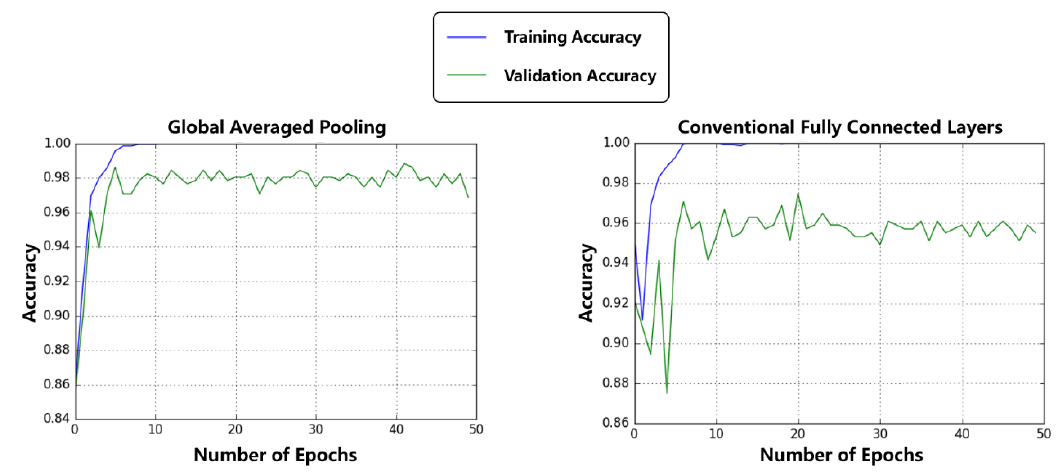
Figure 6. The training accuracy curve and validation accuracy curve of both global averaged pooling method and conventional fully connected layers method.